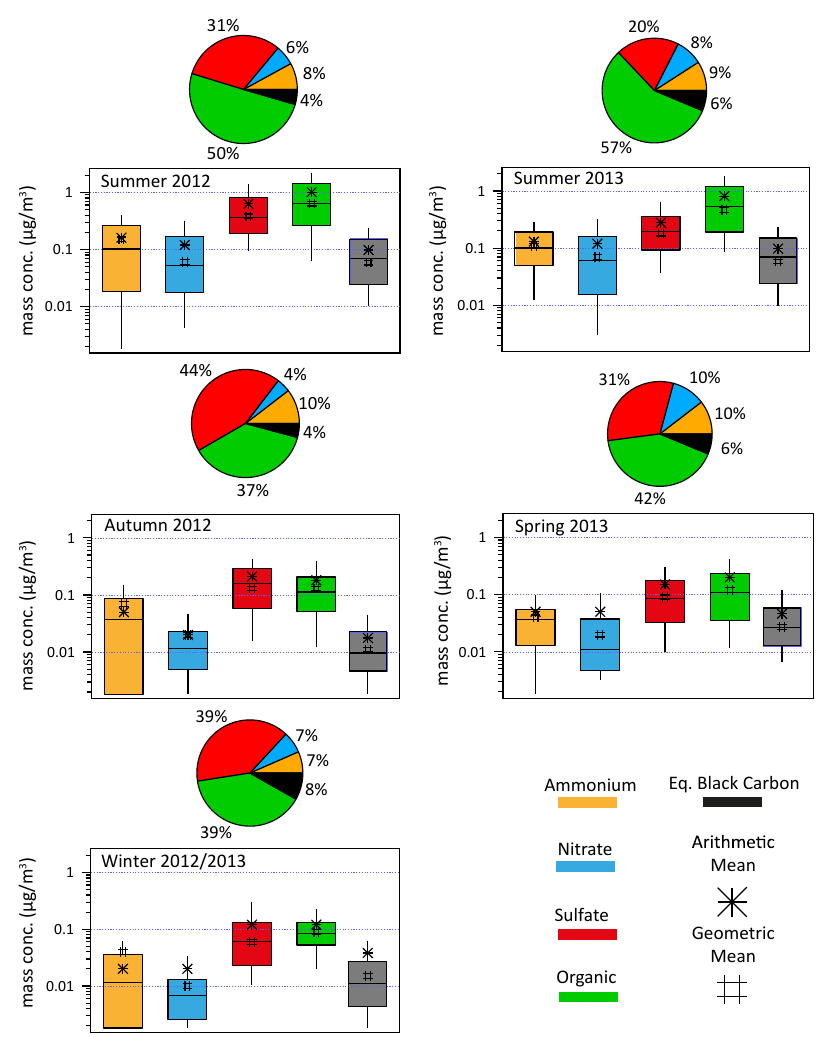
Figure 2. Pie charts of the relative average concentration and boxplots (in µgm − 3 ; line: median; box: interquartile range; whiskers: 10–90th percentile range) separated by seasons (summer 2012, autumn 2012, winter 2012/2013, spring 2013 and summer 2013) for species measured with the ACSM (organic: green; sulfate: red; nitrate: blue; and ammonium: orange) and eBC derived from optical absorption measurements. The arithmetic mean of each species is indicated by a star and the geometric mean by a hash in the respective boxplot. Mean and median concentration values for each species and season can be found in Table 1. Relative concentrations are given in percent in the pie